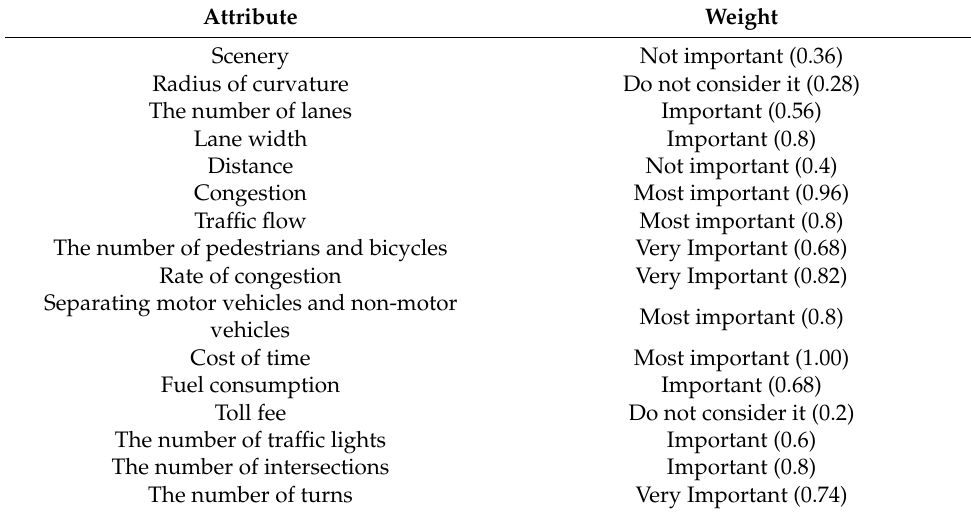
Table 6. The weights of